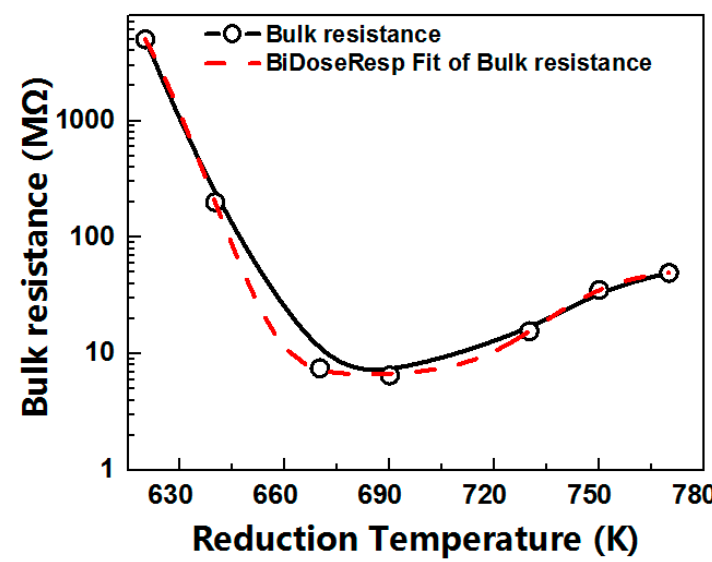
Figure 3. The bulk resistances of the CML865 lead silicate glass MCPs at the reduction temperature controlled from 620 K to 770 K. As the reduction temperature linear increased, the bulk resistances decreased dramatically firstly and increased tardily secondly, showing a BiDoseResp trended bulk resistance-reduction temperature behavior.